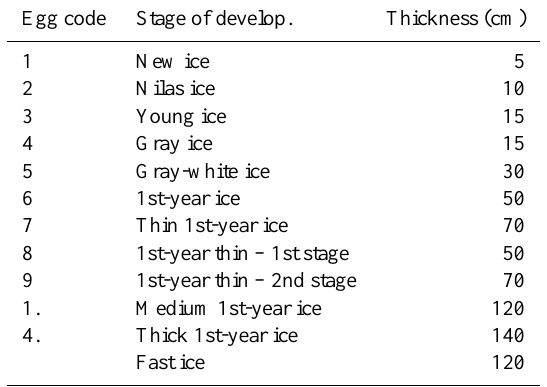
Table 1. Conversion from the egg-code stage of development into ice thickness used here. The multi-year ice types have been ex- cluded. Egg code Stage of